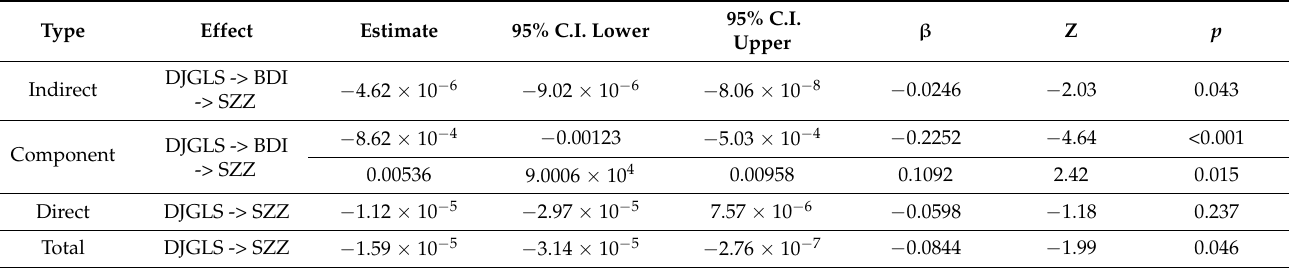
Table 2. Indirect and Total Effects-mediation model 1.